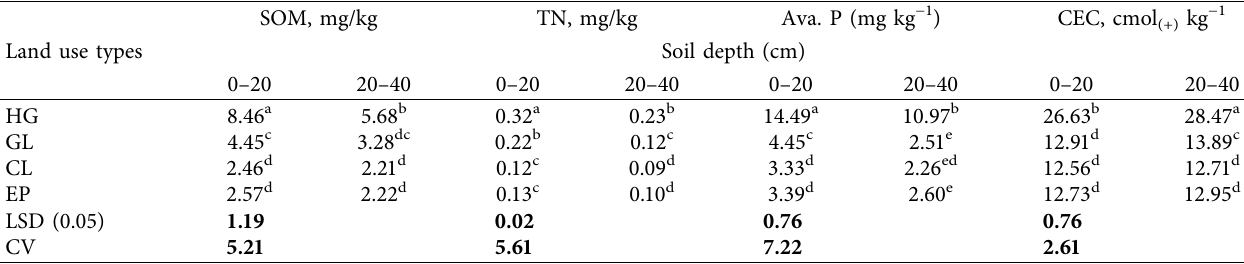
Table 3: Te interaction efects of land use and soil depth on soil SOM, TN, Ava. P, and CEC of the soils in the Hojje watershed ( N � 24). Land use